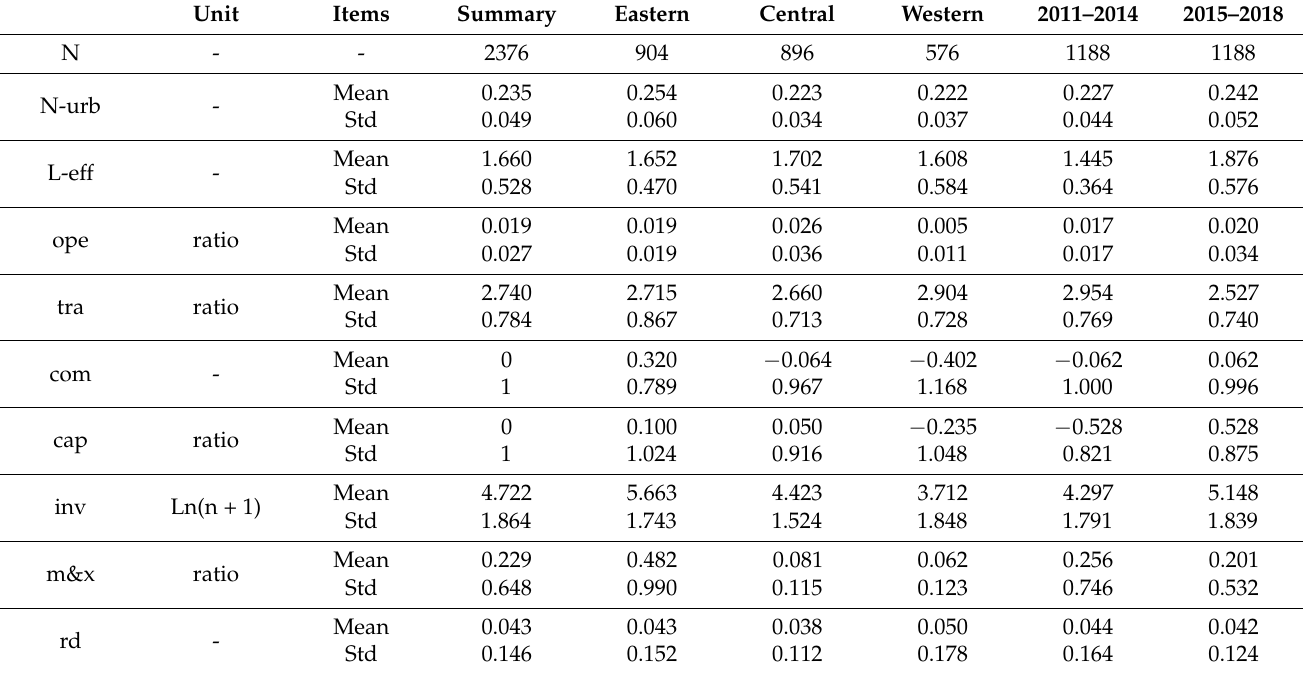
Table 4. Descriptive statistics of